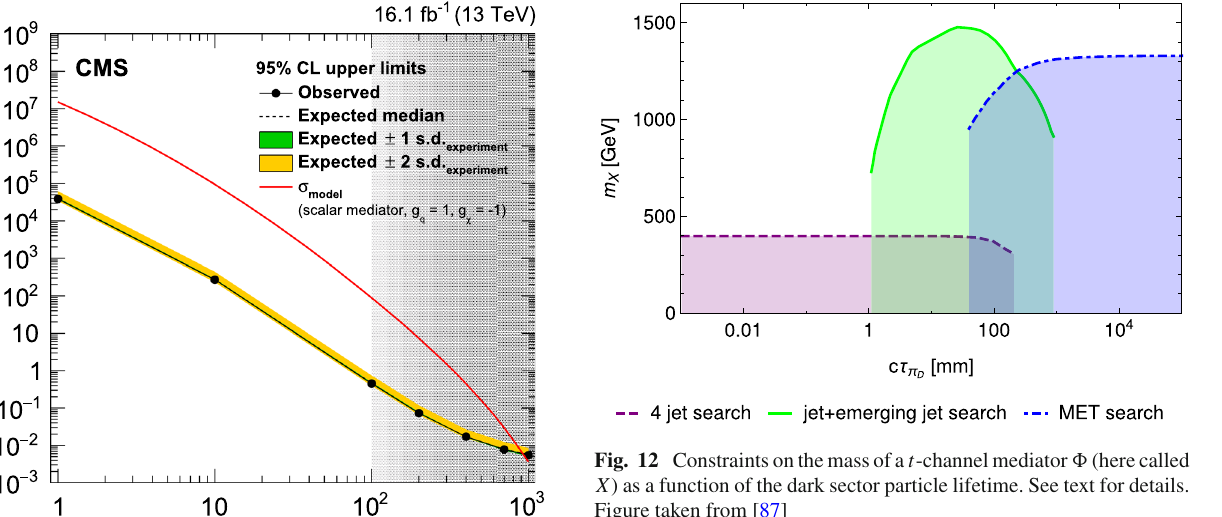
= α peak (here called D D